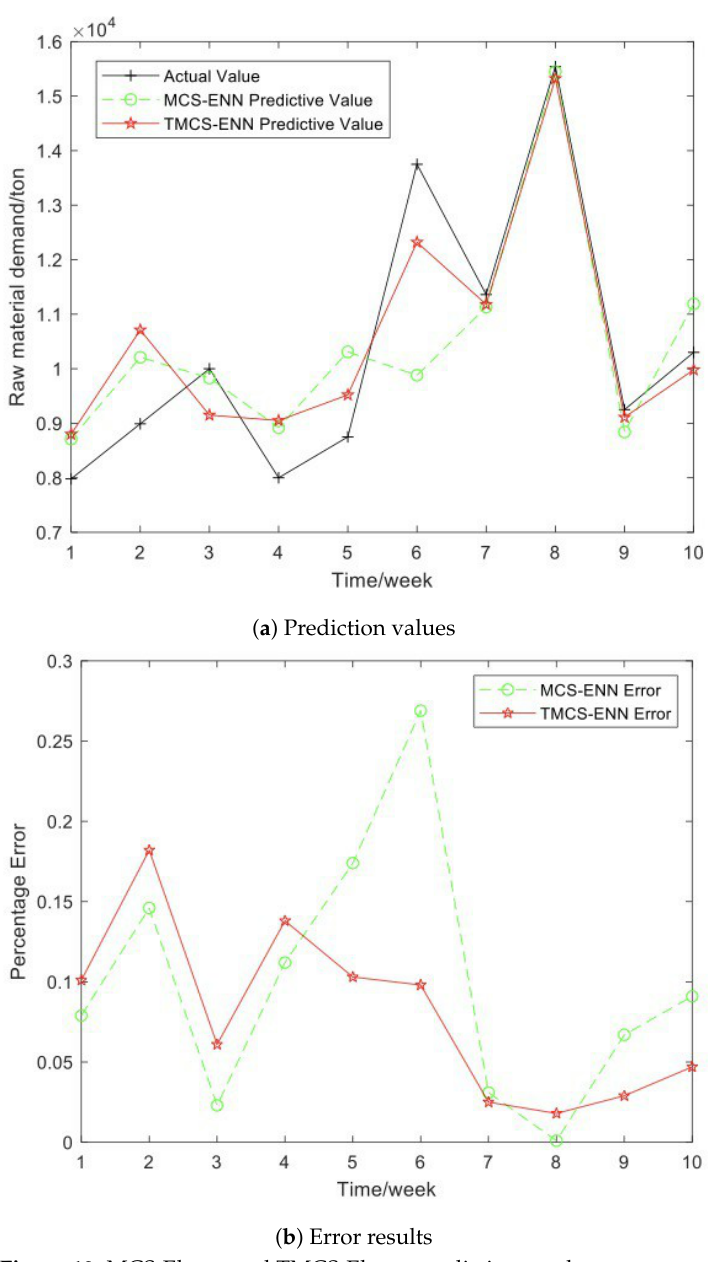
Figure 10. MCS-Elman and TMCS-Elman prediction